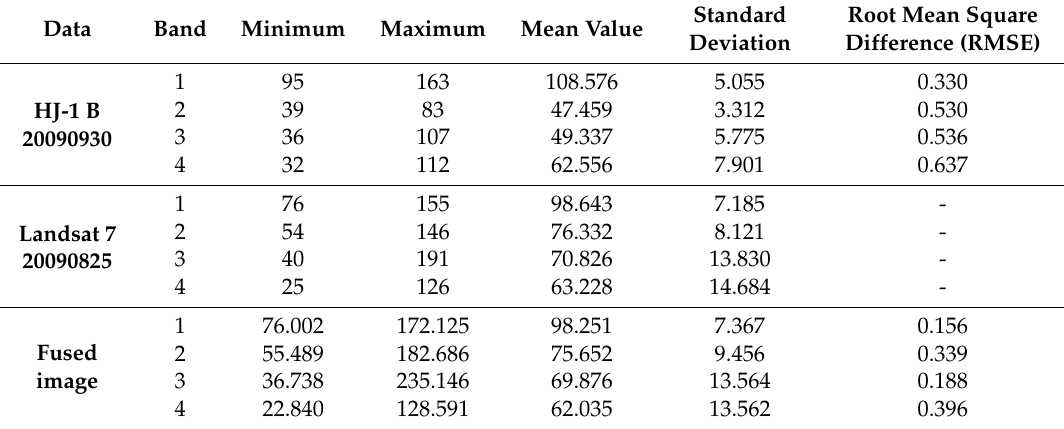
Figure 4. Comparison of remote sensing images (display in standard false color) before and after fusion: ( a ) HJ-1 B (2009-09-30); ( b ) Landsat 7 (2009-08-25); ( c ) Fused image. Table 2. Statistical values before and after fusion in a sample